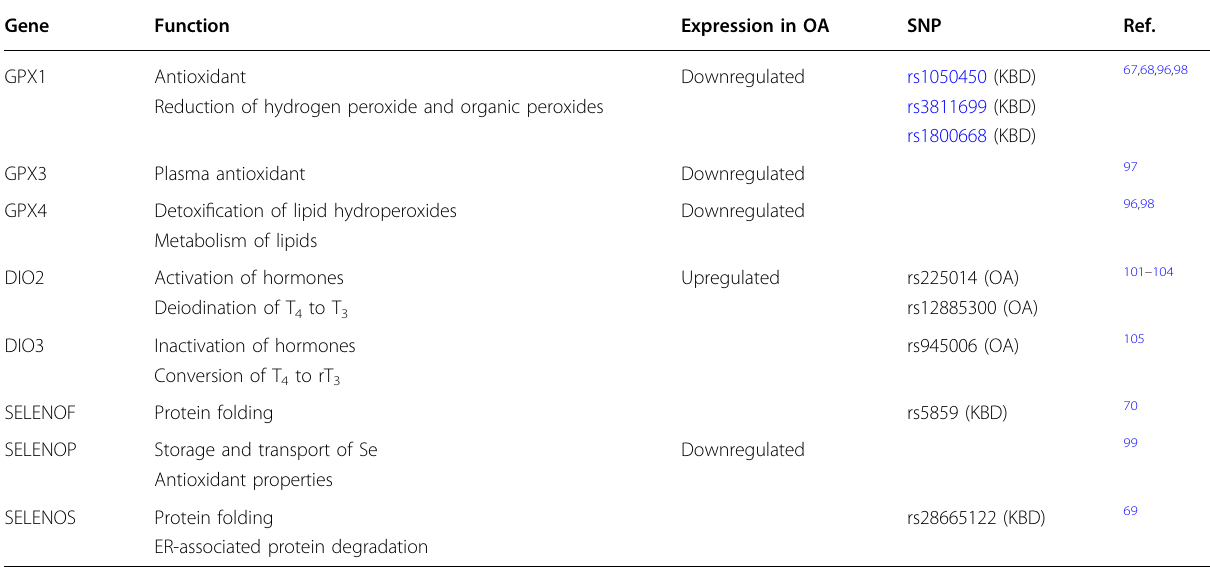
Table 1 List of selenoproteins associated with the pathogenesis of arthropathies, KBD and OA.